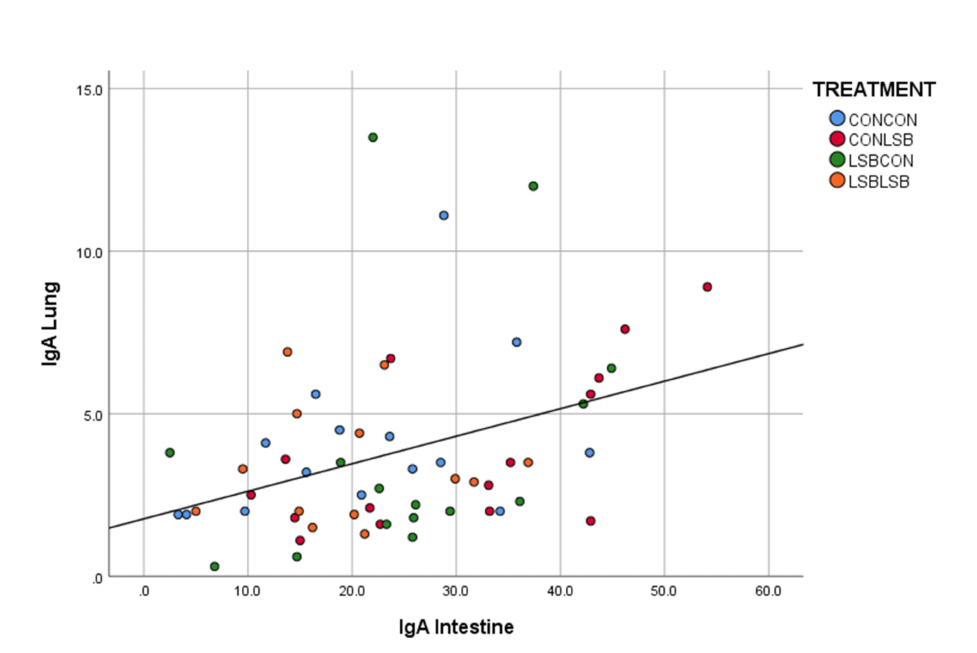
Figure 2. Correlation between the number of IgA producing cells in the intestine and in the lung.